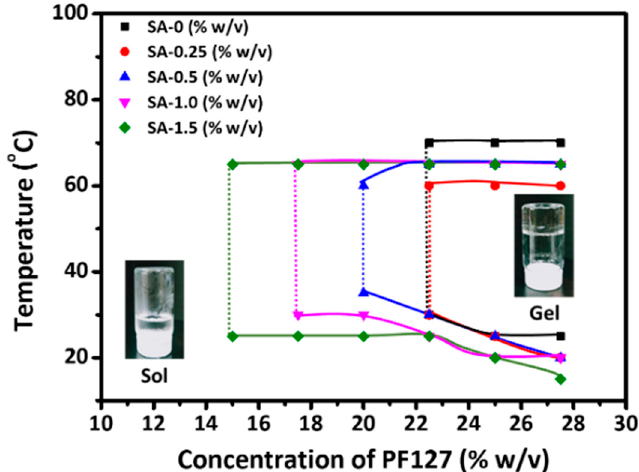
Figure 1. Sol–gel transition diagram of a reversible thermosensitive hybrid hydrogel, prepared by blending SA into PF127. The hybrid hydrogel consisting of different concentrations of PF127 (12.5–27.5% w/v ) and amounts of SA (0–1.5% w/v ) was subsequently assessed by using the tube-inversion method at increasing temperature (5–70 °C) (three measurements for each point). SA, sodium alginate